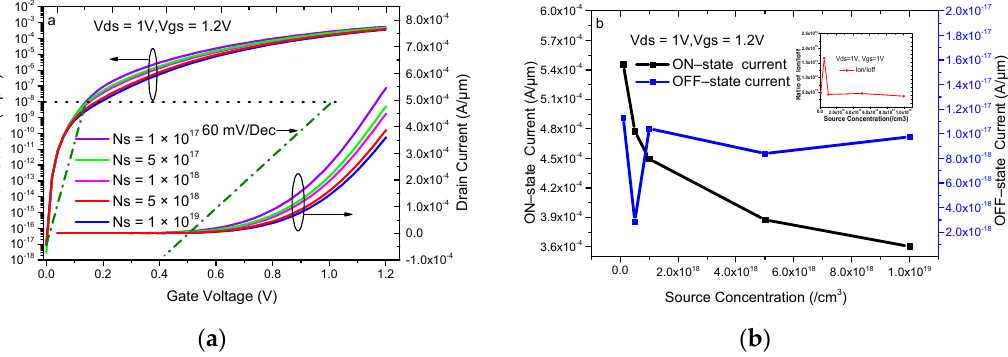
Figure 6. ( a ) Transfer characteristics of the DMGE-HJLTFET with different source doping ( a ) Transfer characteristics of the DMGE-HJLTFET with di ff erent source doping concentration; ( b ) variation of ON-state current, OFF-state current and Ion/Ioff with different source concentration; ( b ) variation of ON-state current, OFF-state current and Ion / Io ff with di ff erent source doping concentration. doping